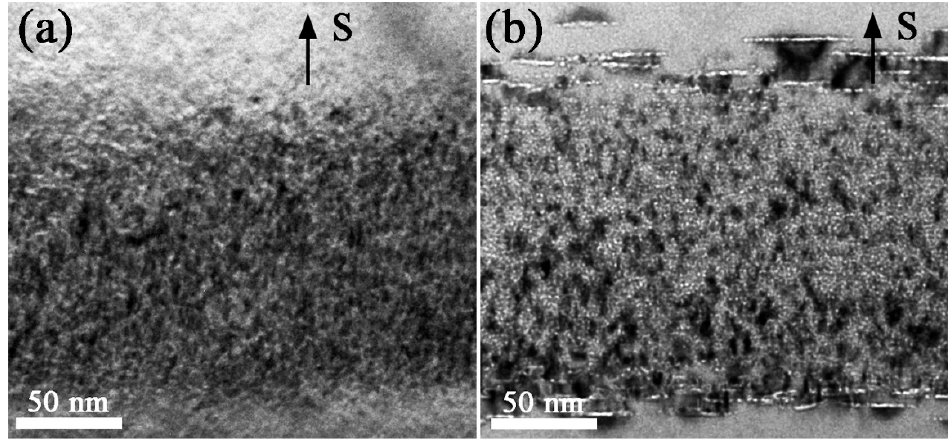
Figure 1. Bright field TEM images showing the 6H-SiC samples implanted with 1 × 10 17 ions/cm 2 fluence at 400 °C: ( a ) as-implanted; ( b ) annealed at 900 °C for 30 min. The letter “S” and black arrows indicate the irradiation surface.